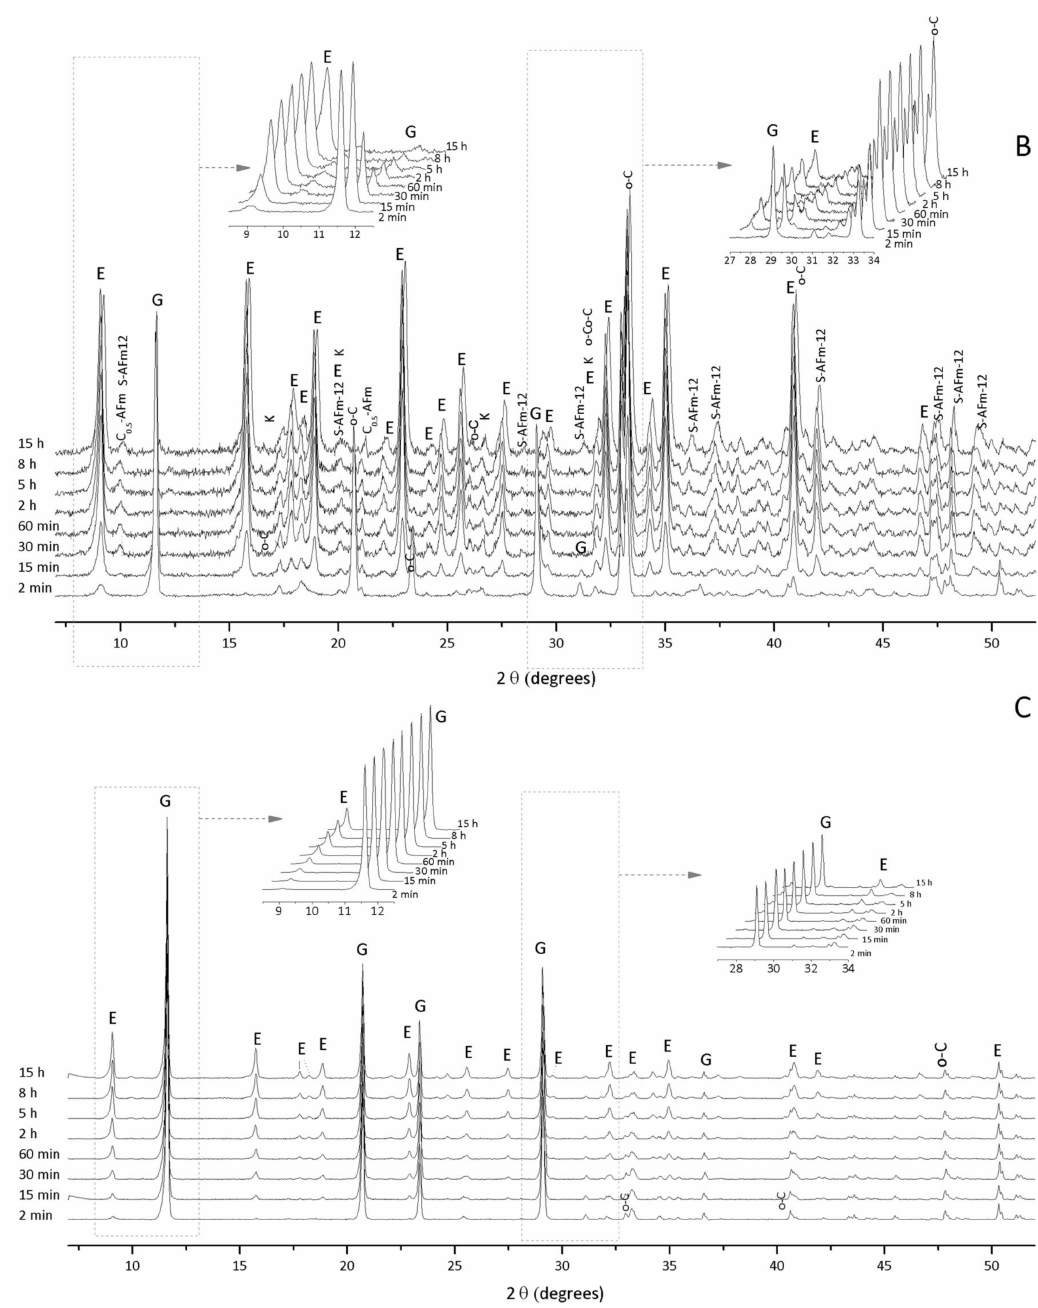
Figure 4. In situ XRD results of orth-C 3 A and gypsum hydration at gypsum/orth-C 3 A ratios of ( A ) 0.20; ( B ) 0.60; and ( C ) 1.90. o-C = orth-C 3 A, E = ettringite, G = gypsum, OH-AFm = C 4 AH 19 ; k = katoite (C 3 AH 6 ), C 0.5 -AFm = calcium hemicarboaluminate hydrate; S-AFm =